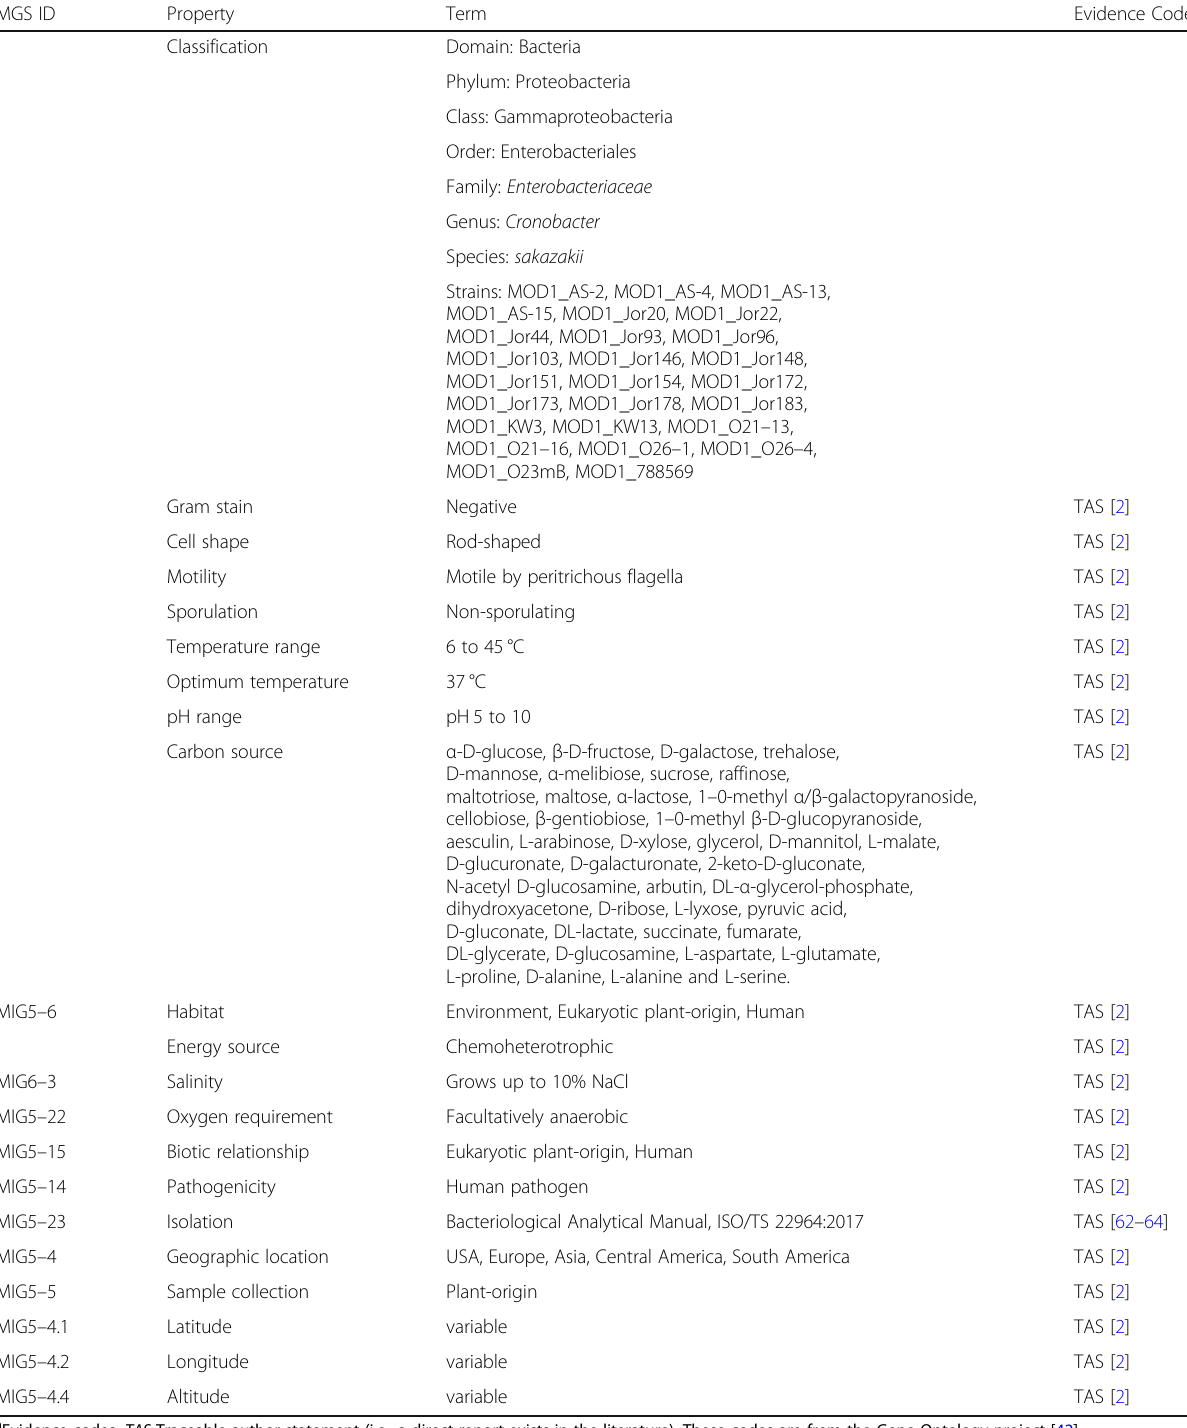
Table 1 Classification and general features of C. sakazakii strains used in this study MGS